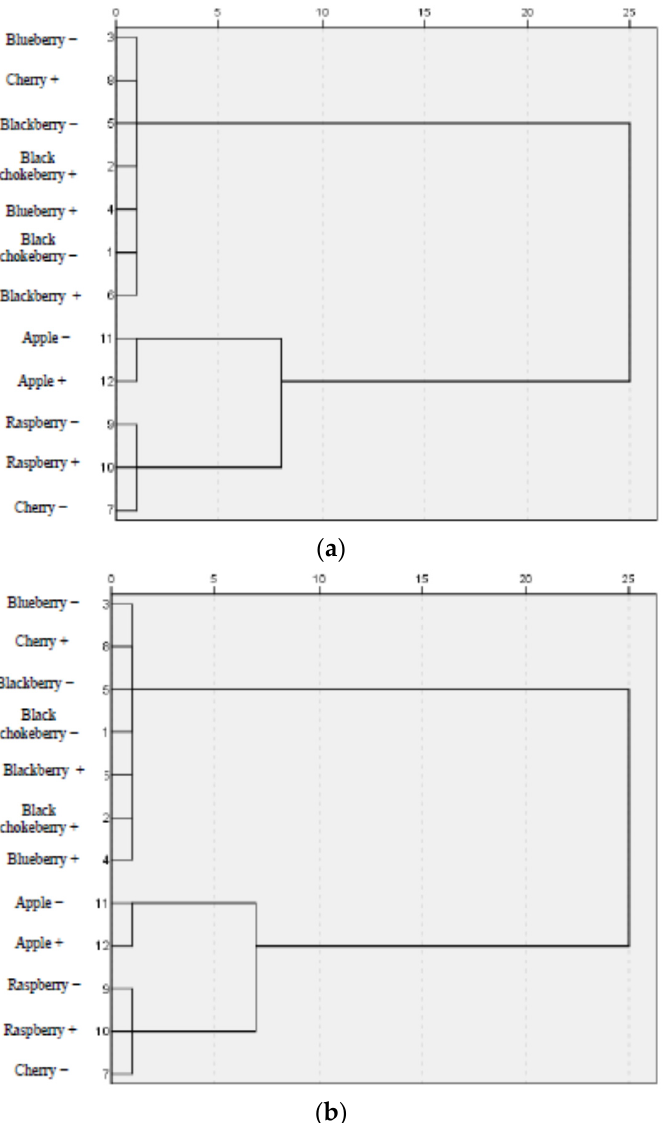
Figure 3. Dendrograms for the distribution of fruit wines; ( a )—Lievito Secco yeast, ( b )—ICV D254 yeast; + with sugar and enzyme, − without sugar and enzyme.